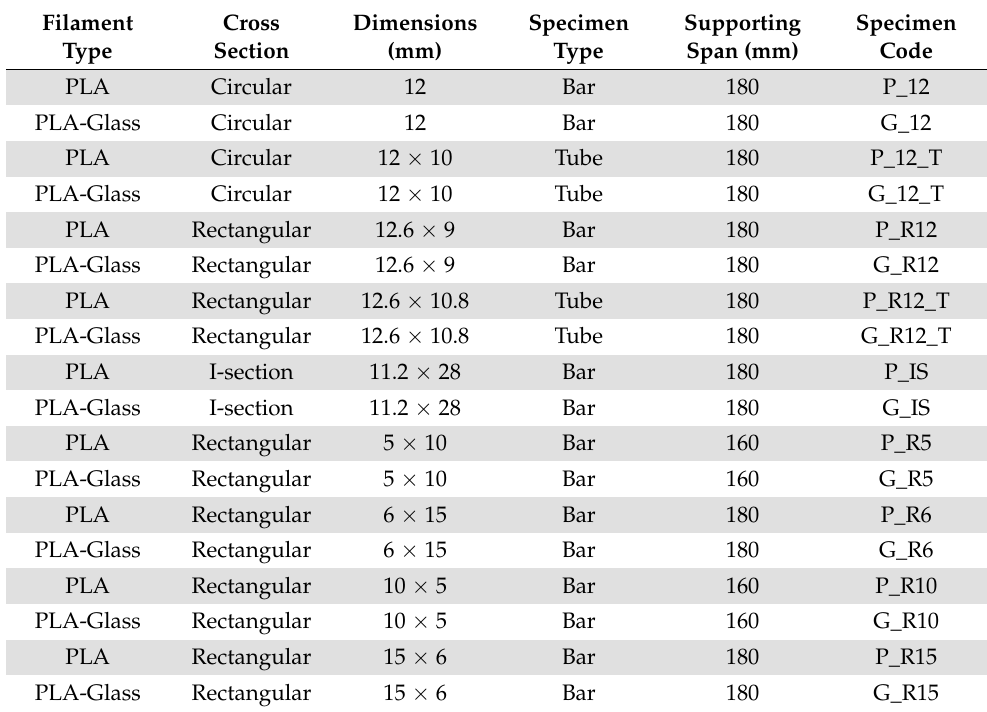
Table 1. Specimen characteristics and codification